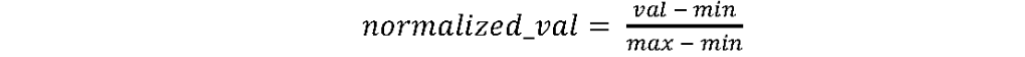
Fitbit provides a rich set of information about the wearer’s